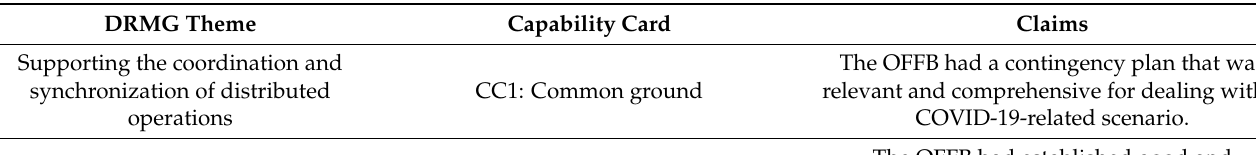
Table 2. Themes, capability cards, and interview